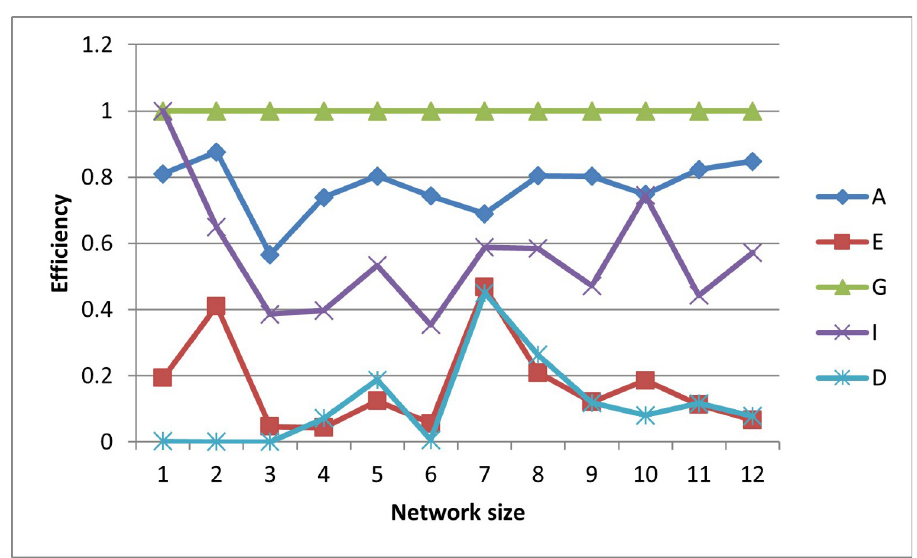
Fig 19. G-efficiencies of various optimal designs for the second case